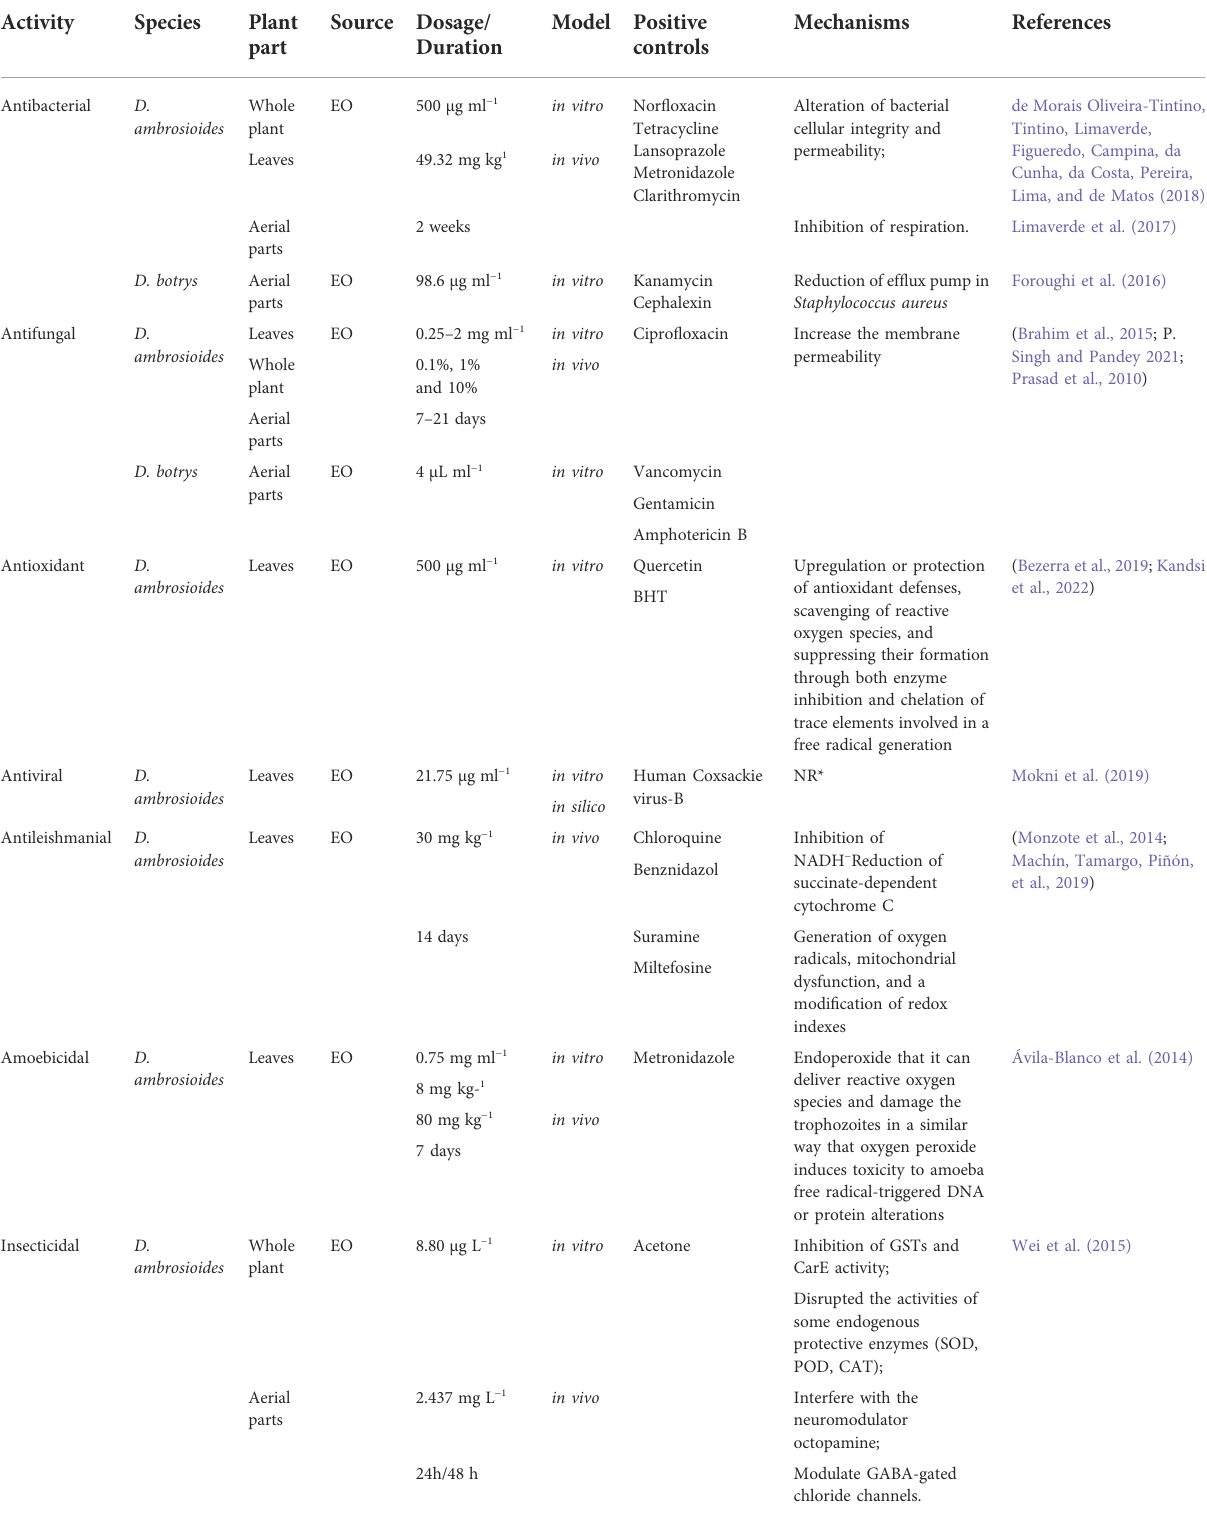
TABLE 4 Biological effects of Dysphania Spp